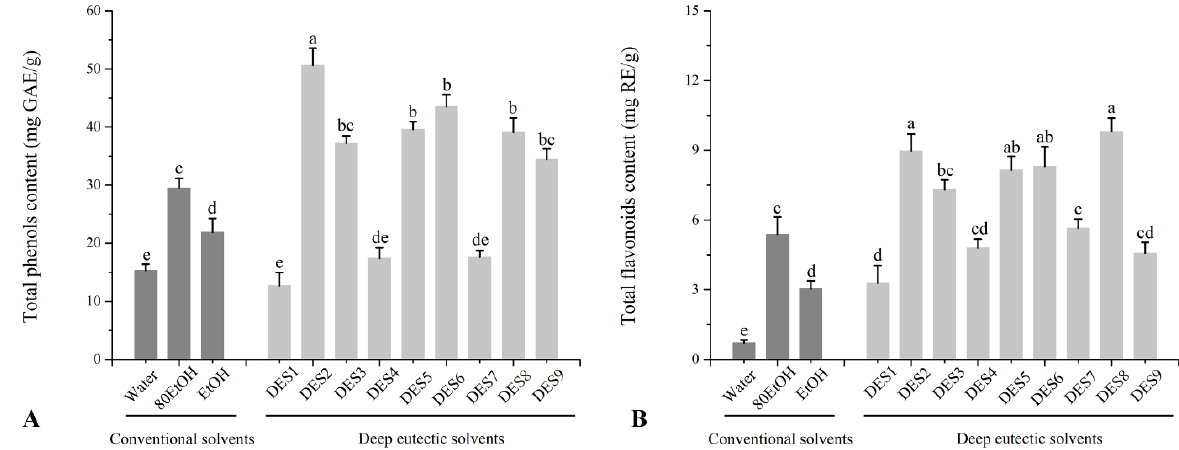
Figure 1. Effect of extraction solvent (conventional and deep eutectic solvents) on ( A ) total phenolic and ( B ) flavonoids contents of ginger extract. The corresponding to the solvent’s abbreviations can be consulted in Table 1. Values are expressed as mean ± SD ( n = 3). Different letters in each series indicate significant differences ( p < 0.05); lowercase letters denote significant differences ( p < 0.05) between solvents.